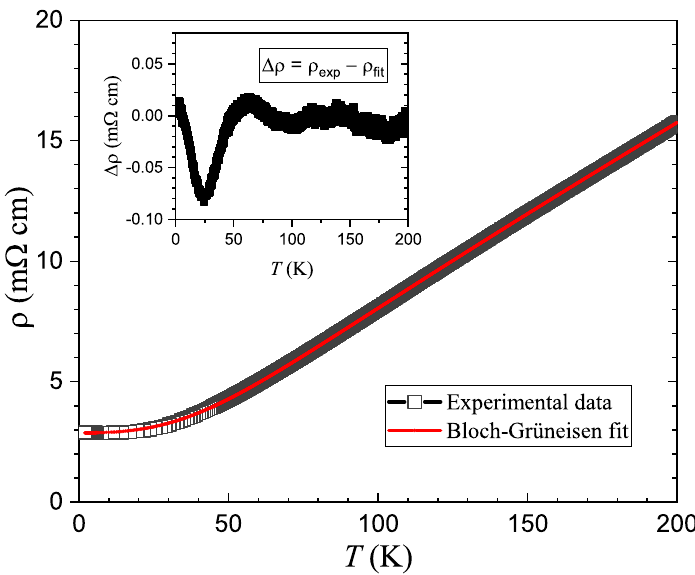
Figure 2. Temperature dependence of electrical resistivity of the Sr 2 Cr 2 AsO 3 polycrystalline sample. The solid line is a fit with the extended Bloch-Grüneisen formula (see the text). The inset shows the difference, ∆ ρ , between the experimental and fitted data. The drop in ∆ ρ by ∼ 3% below 70 K suggests reduction of the magnetic scattering by Cr(1)